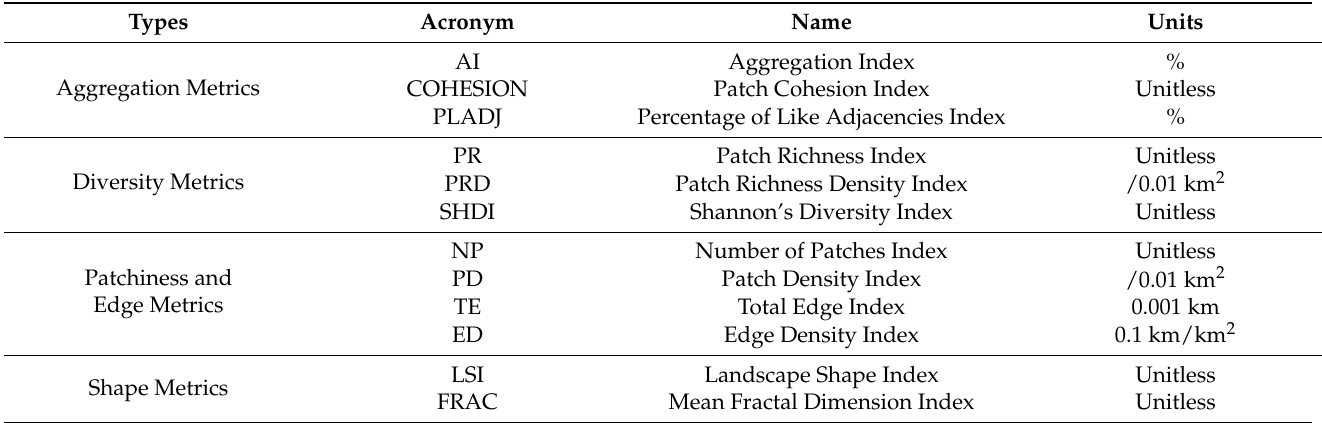
Table 1. The 12 landscape